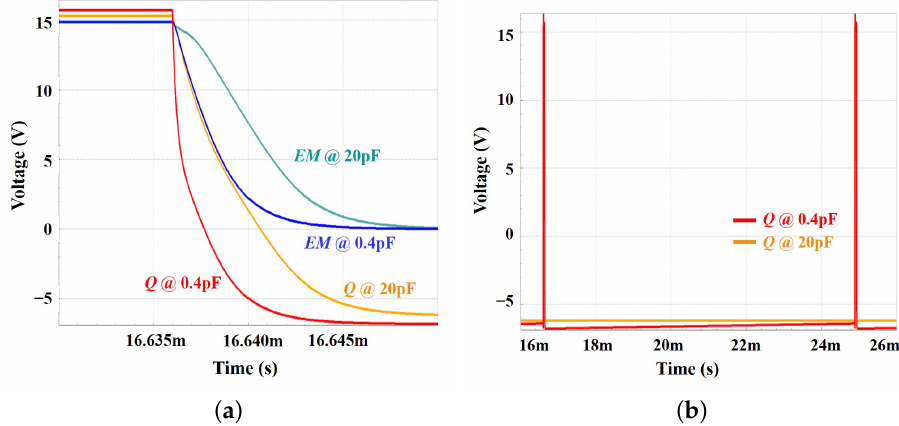
Figure 13. Comparison of Q and EM performance over the capacitance of C1 , 0.4 and 20 pF: ( a ) bootstrapping at Q and EM ; and ( b ) holding effect at Q .